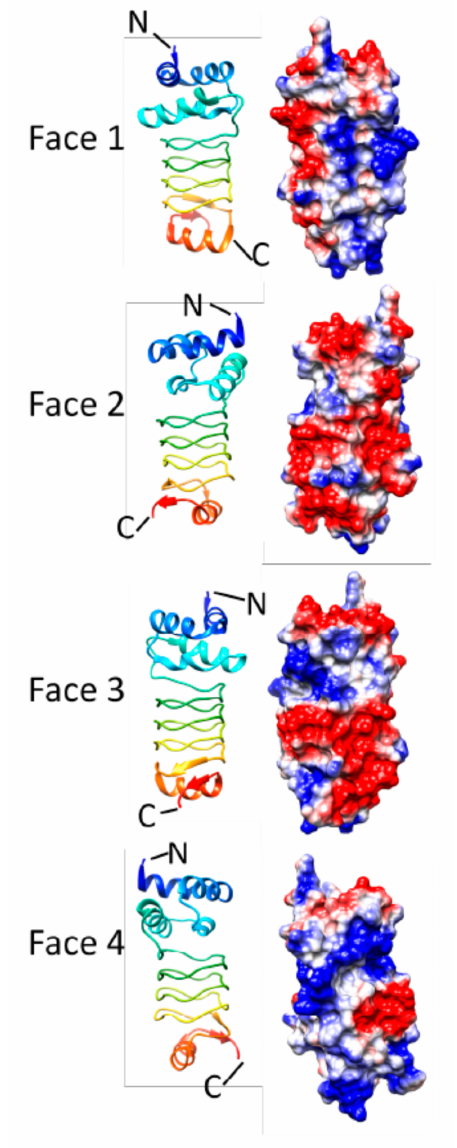
Figure 14. Structure and analysis of Alr1298. Ribbon diagrams of the structure (PDB ID: 6UV7) for four